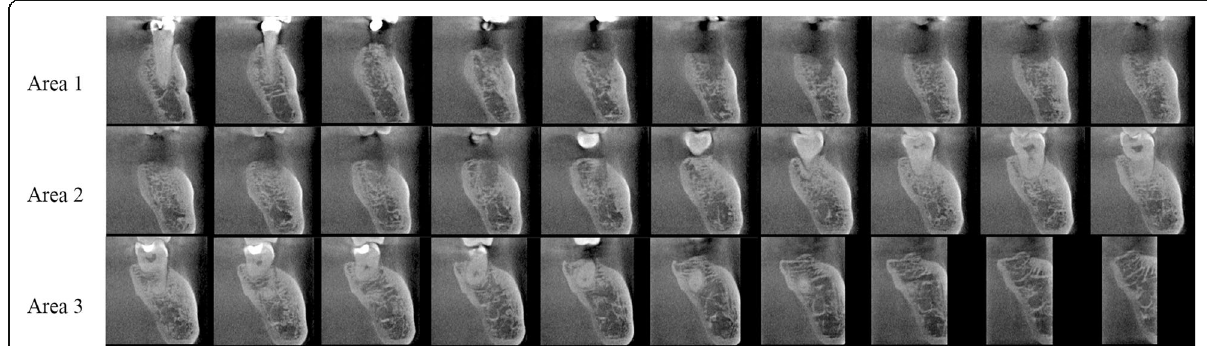
Fig. 4 Cross-sectional images of areas 1 – 3 of a 39-year-old female. The visibility ratios for the superior wall in areas 1, 2, and 3 were 0.2, 0.9, and 0.9, respectively, whereas those of the inferior wall were 0.7, 0.9, and 1.0, respectively